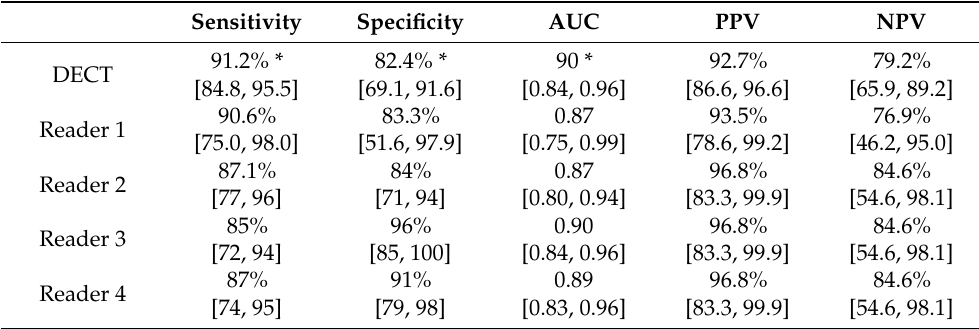
Table 3. Diagnostic performance of four readers at DECT for diagnosing presence of bone marrow edema, giving MRI as gold standard.